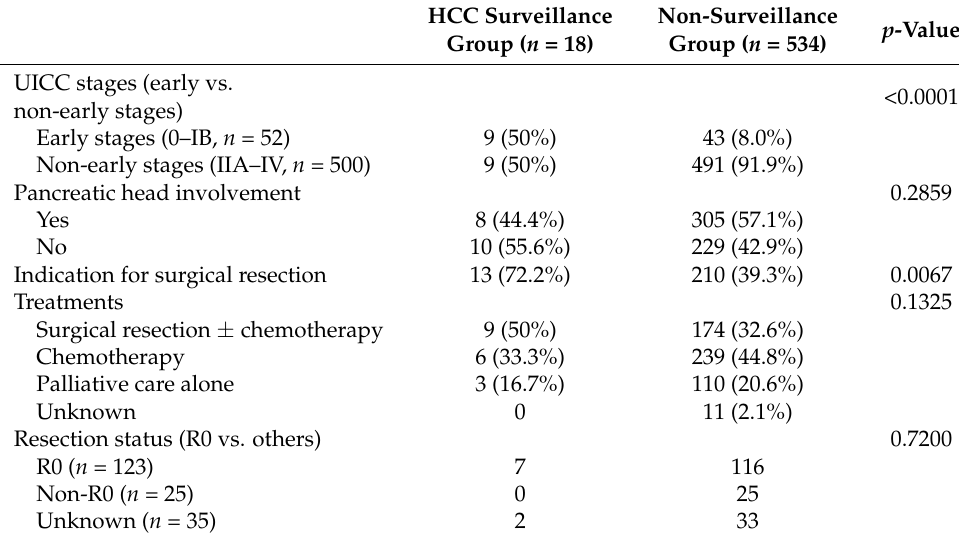
Table 2. UICC stages and treatments in patients with